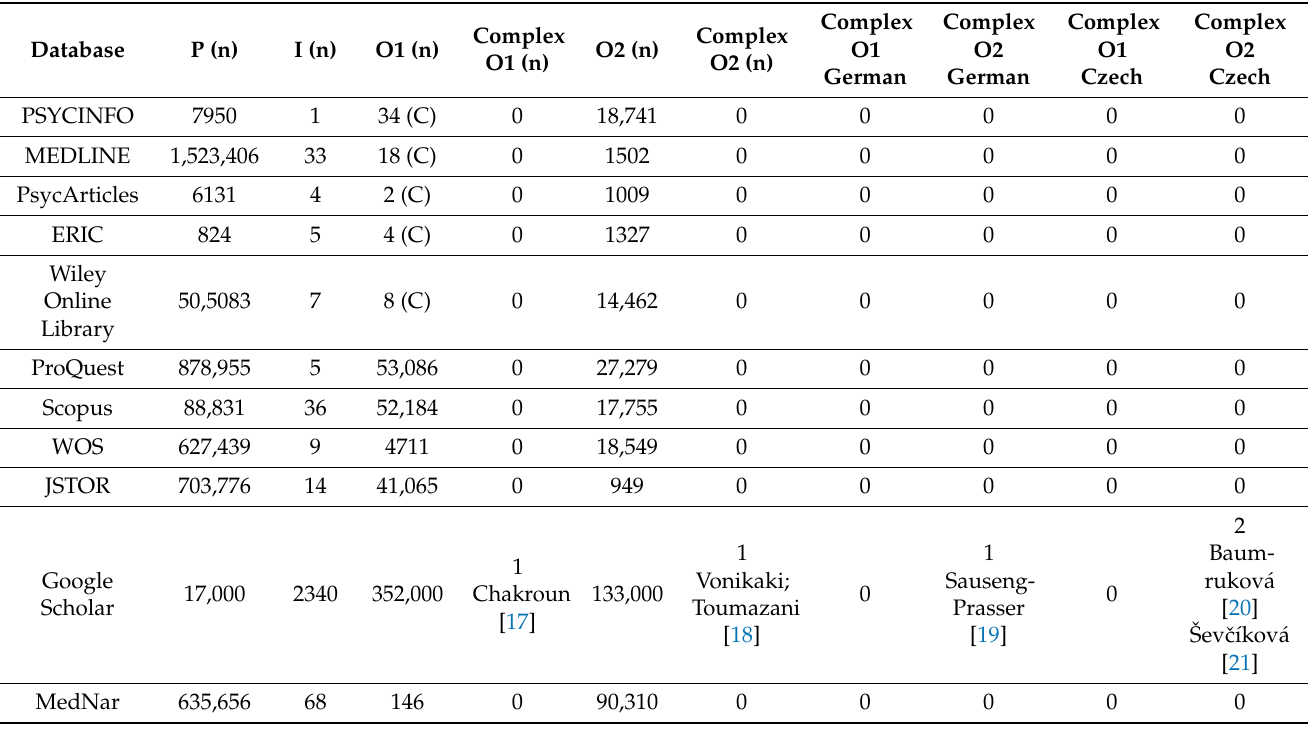
Table 1. Results for P, I, O1, O2, and complex searches in the English, German, and Czech